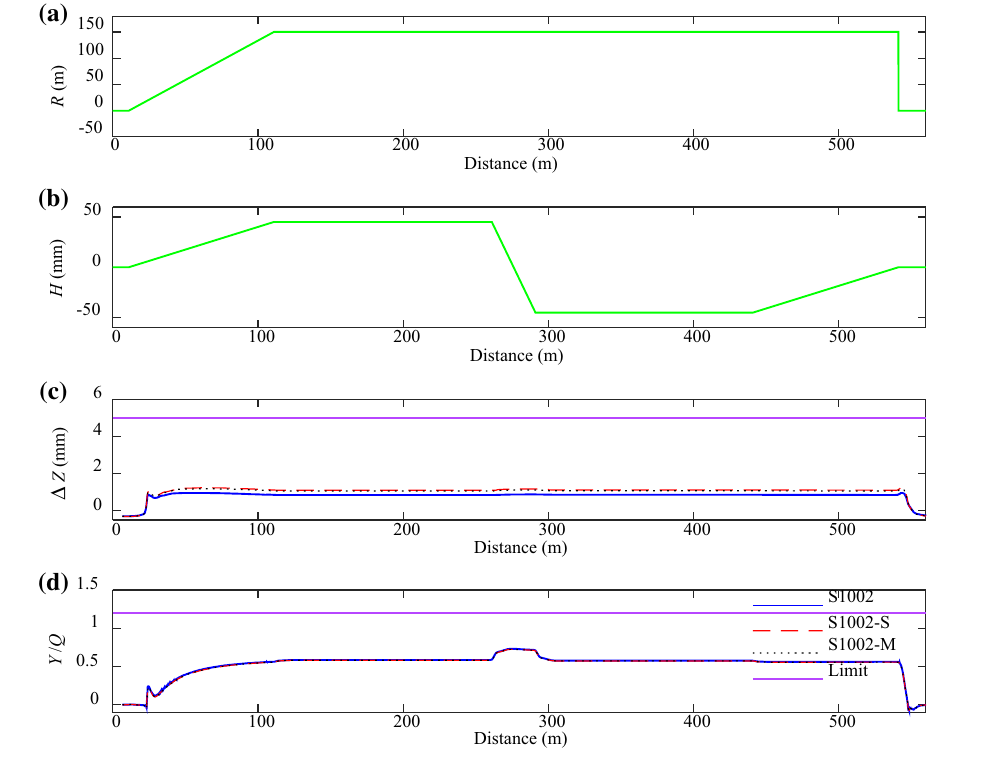
Fig. 18 Track layout of radius ( a ) and superelevation ( b ) according to EN 14363 and comparison of wheel lift ( c ) and derailment quotient Y = Q ( d ) between the S1002, S1002-S and S1002-M